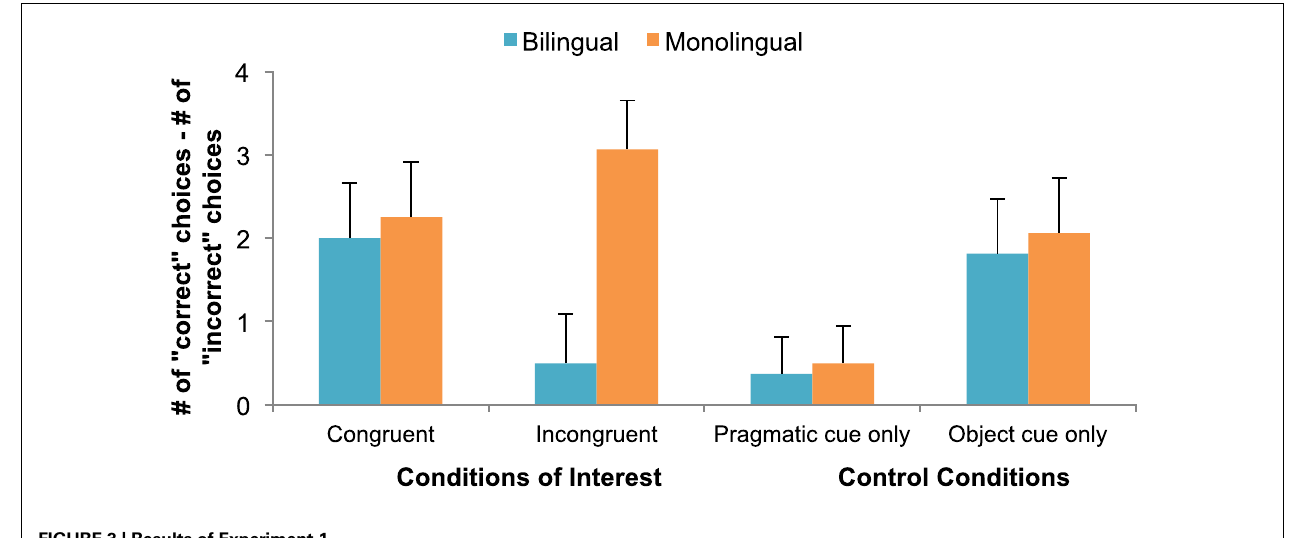
FIGURE 3 | Results of Experiment 1.